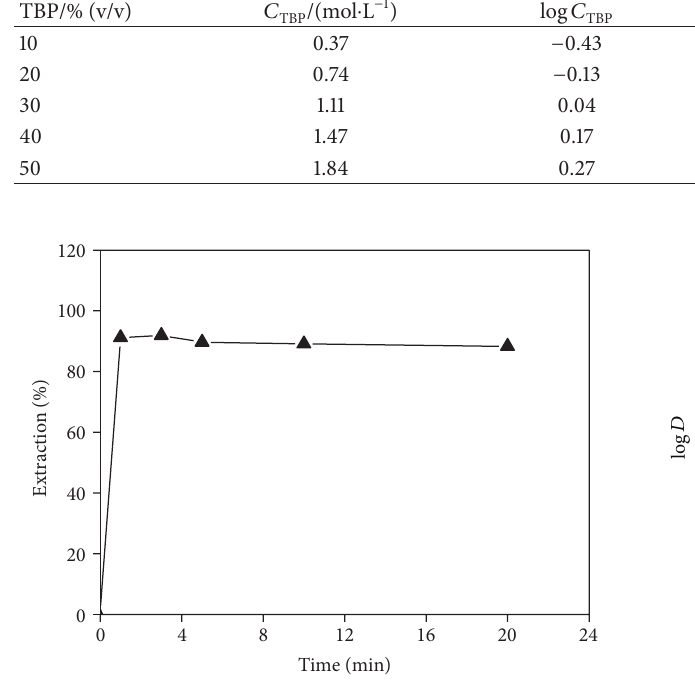
𝐷 as a function of log TMP